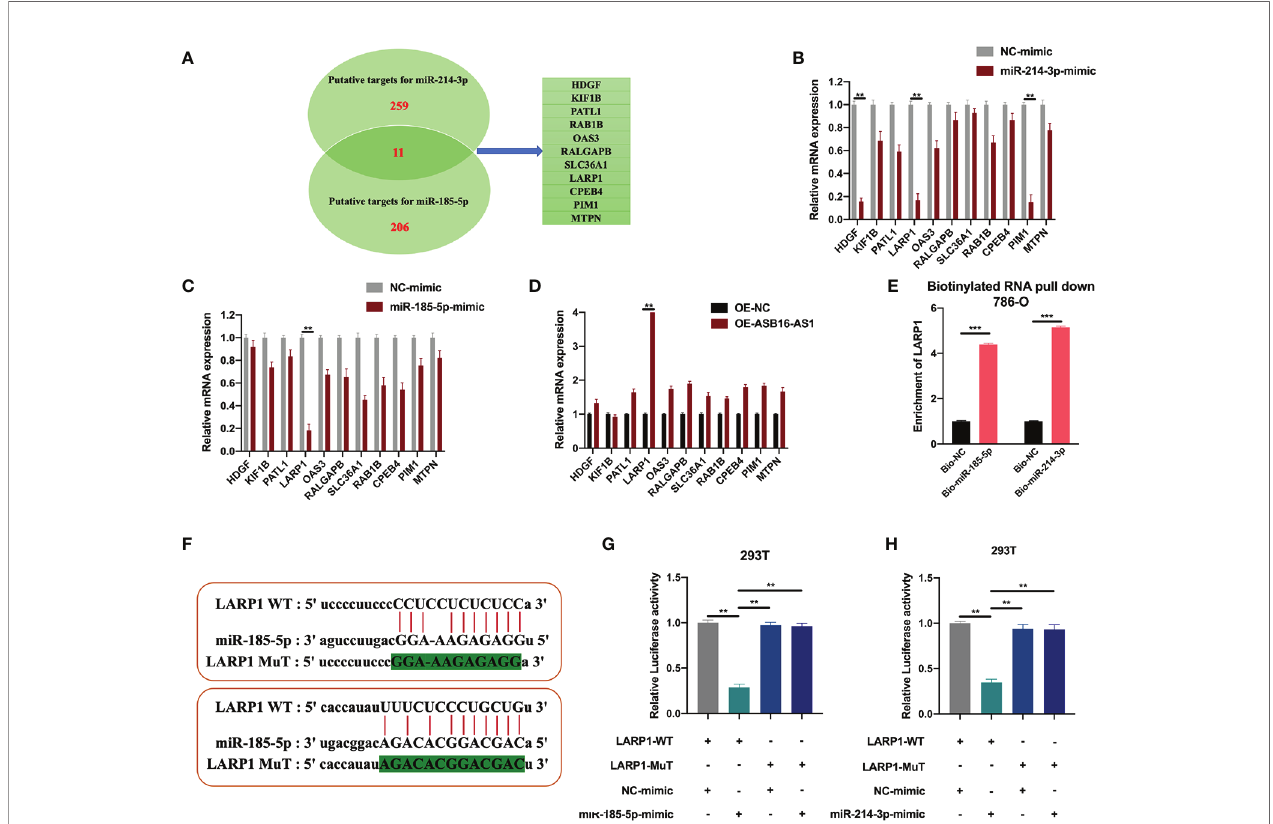
FIGURE 6 | LARP1 is a downstream target for miR-185-5p/miR-214-3p. (A) The downstream targets of miR-185-5p and miR-214-3p were predicted using the ENCORI database (http://starbase.sysu.edu.cn/index.php), with CLIP Data; high stringency (>=3) and Predicted program (microT, miRanda, miRmap, and PITA). Eleven potential mRNA targets were chosen. 786-O cells were transfected with NC-mimic/miR-185-5p mimic, NC-mimic/miR-214-3p, and OE-NC/OE-ASB16-AS1, respectively. (B – D) Relative mRNA expression of potential target mRNAs, measured by qRT-PCR. (E) Biotinylated RNA pull-down assays were performed and qRT- PCR experiments were conducted to determine the enrichment of LARP1 in Bio-NC/Bio-miR-185-5p, Bio-NC/Bio-miR-214-3p treated 786-O cells. (F) Wild-type (WT) and mutated (MUT) sequences of the putative LARP1 miR binding sites aligned with miR-185-5p, and miR-214-3p. (G, H) Luciferase reporter activity of Luc- LARP1-WT or MUT in 293T (G) and 786-O cells (H) after transfection with miR-185-5p and miR-214-3p mimics and NC-mimic. All experiments were repeated at least three times. **P < 0.01, ***P <